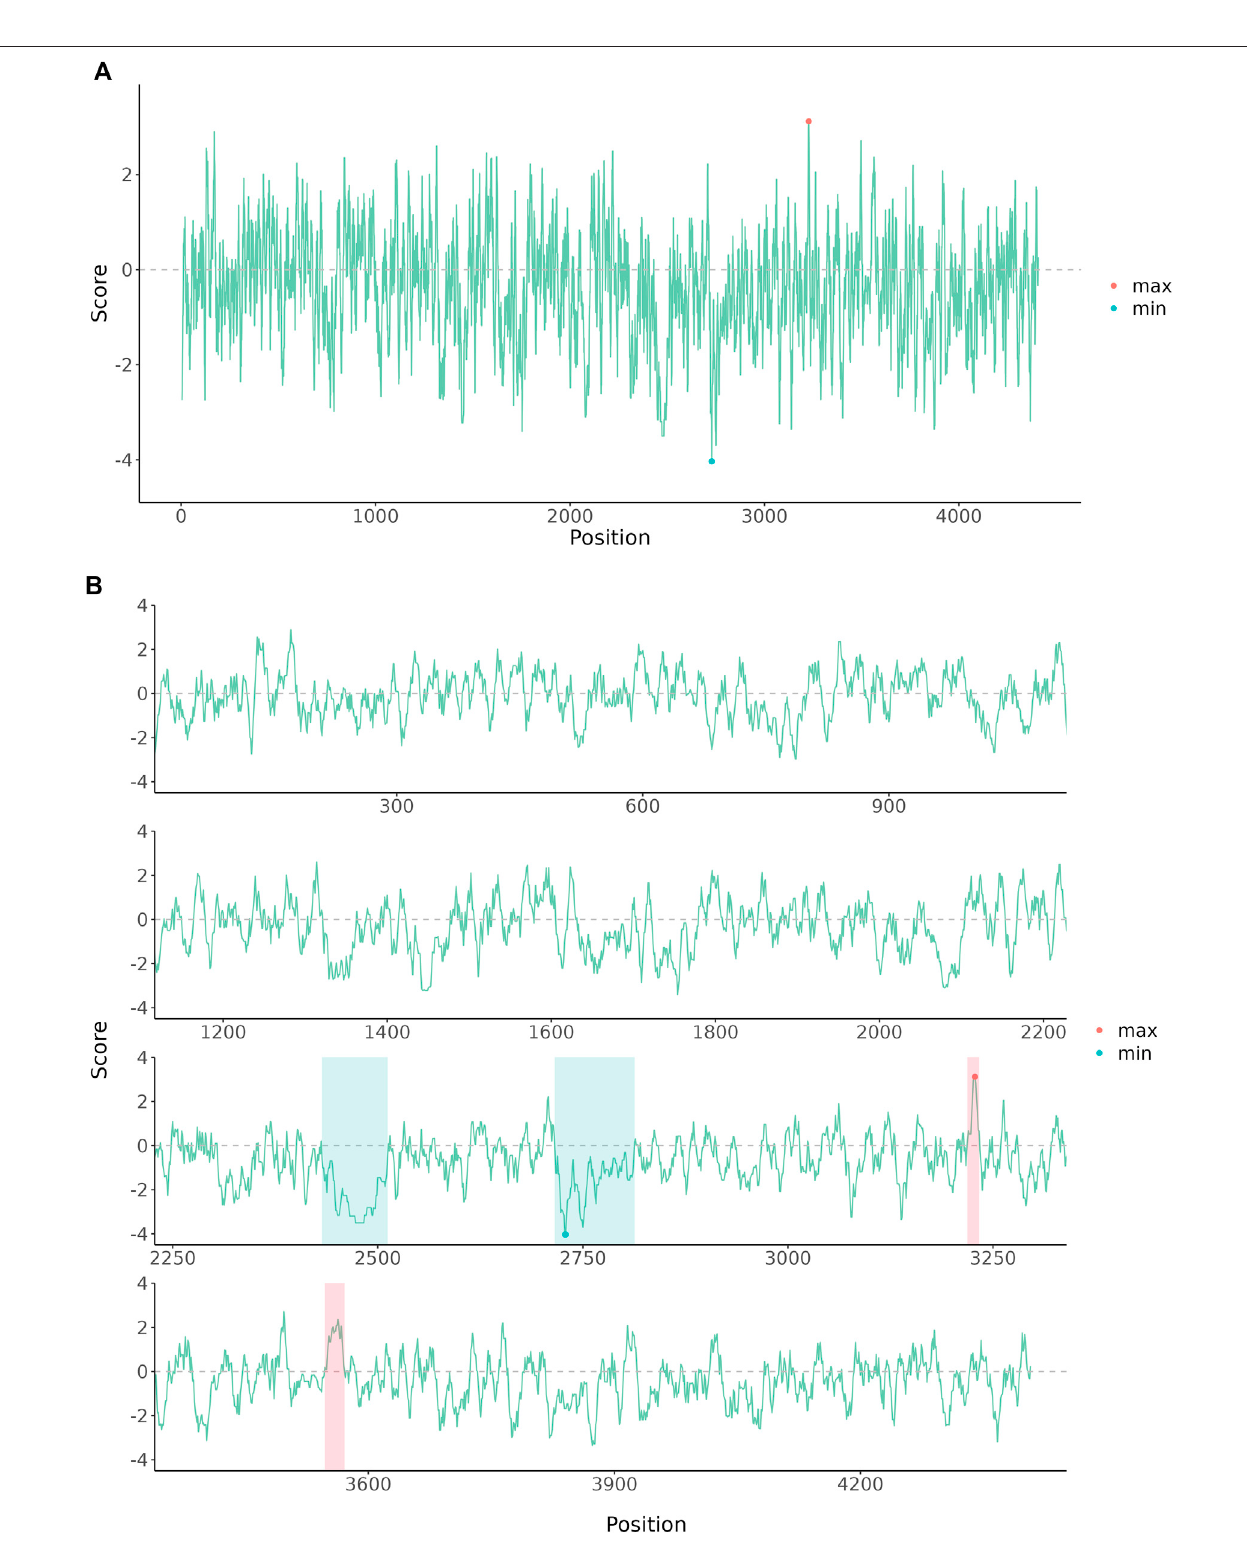
FIGURE 1 | The amino acid hydrophobicity or hydrophilicity scales of human E3 ubiquitin-protein ligase HUWE1 Chain A. The protein sequence was downloaded fromtheNCBIdatabase(PDB:7MWE_A). (A) Theoriginalplotoftheaminoacidscales. (B) Theaminoacidscaleswerewrappedintofourrowsandfurtherannotatedto highlight hydrophilicity and hydrophobicity regions.